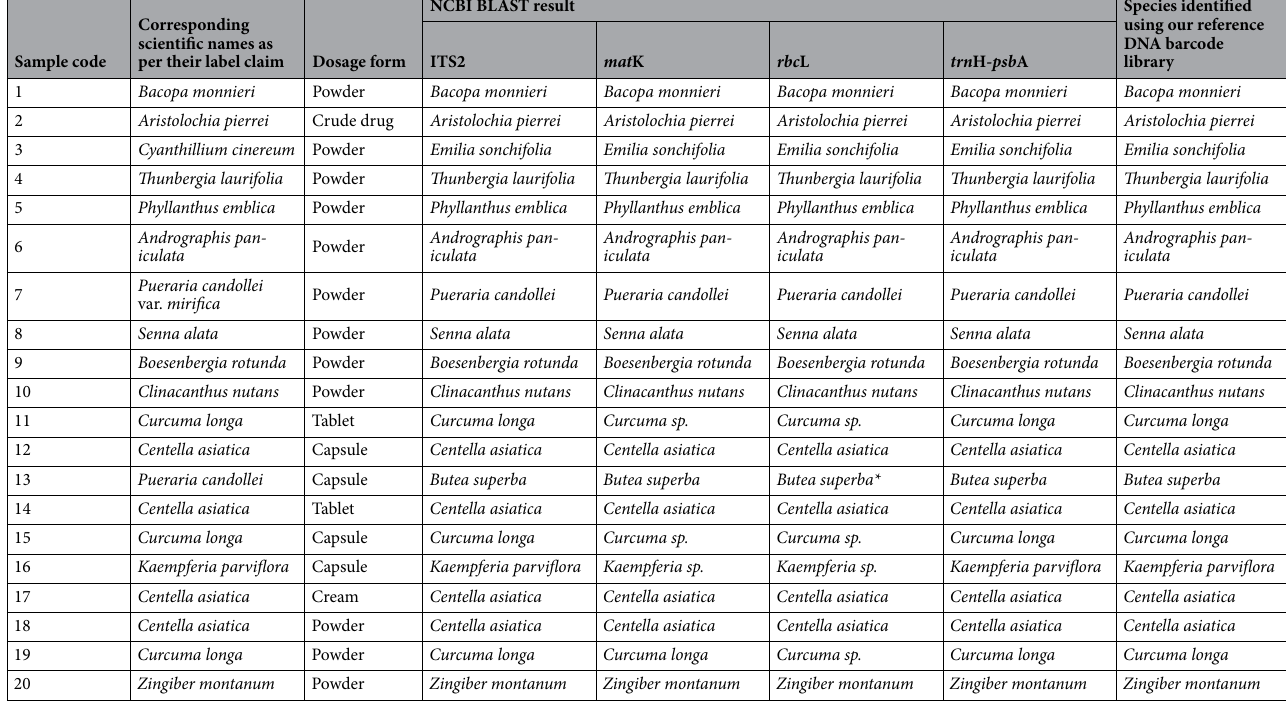
Table 2. Nucleotide sequence BLAST results of herbal products. *Indicates that the Barcode of Life Data System (BOLD) database was used for sample